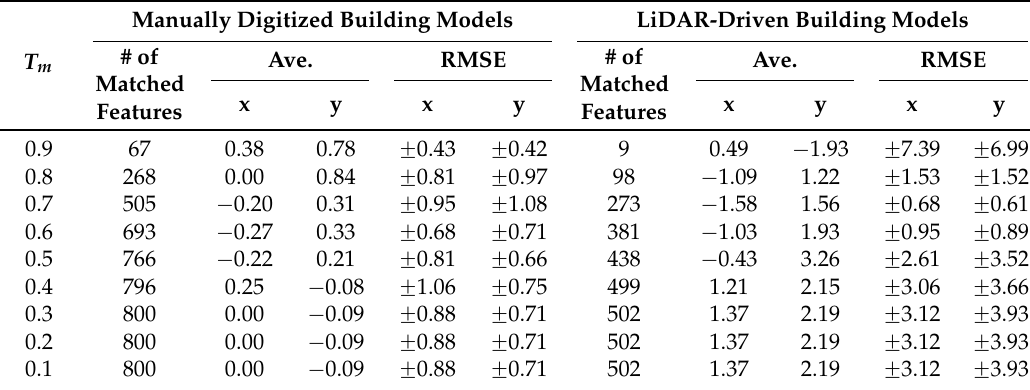
Table 5. Effect for T m (unit: pixel).